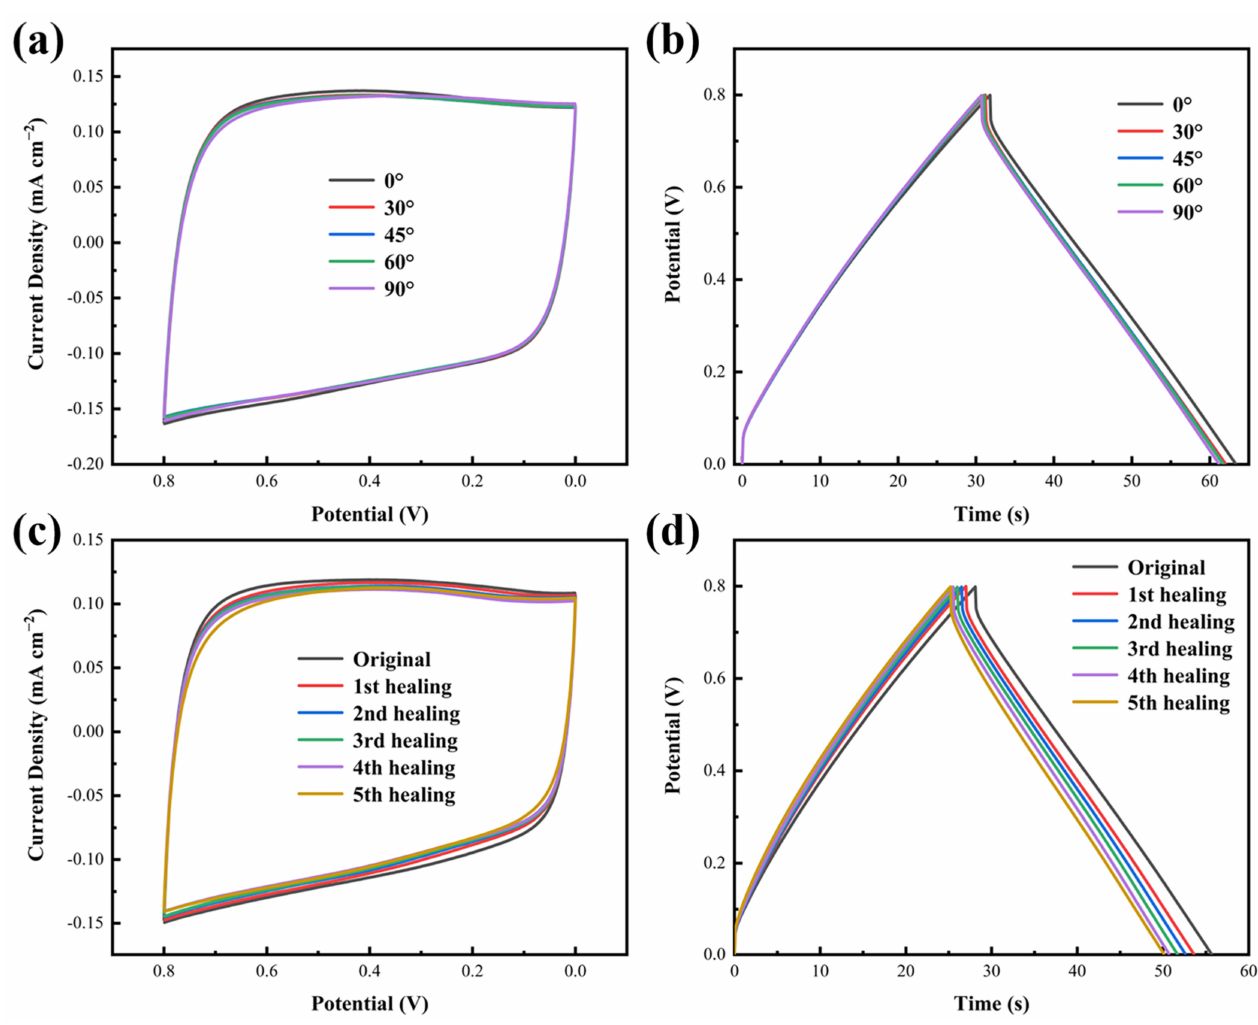
Figure 8. ( a ) CV curves (20 mV s − 1 ) of the MSC at different bending angles. ( b ) GCD curves (150 µ A cm − 2 ) of the MSC at different bending angles. ( c ) CV curves (20 mV s − 1 ) of the MSC at different damage/self-healing cycles. ( d ) GCD curves (150 µ A cm − 2 ) of the MSC at different damage/self-healing